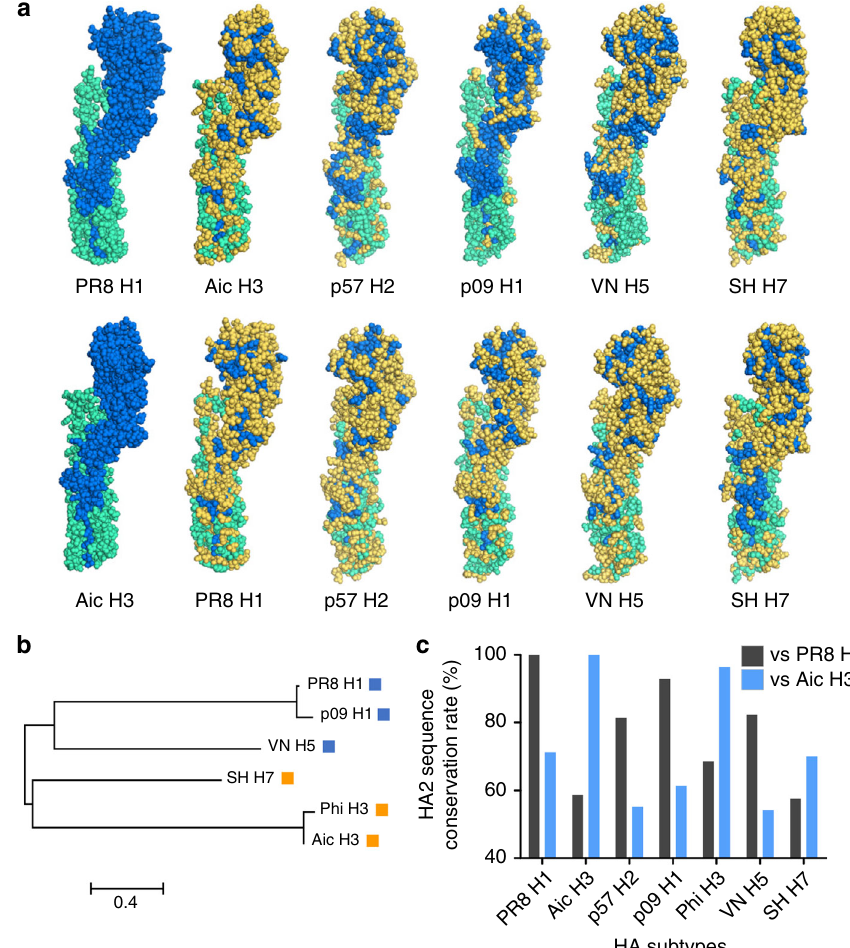
Fig. 4 Amino acid differences in HA structures. a Three-dimensional spherical structures of diverse hemagglutinin proteins with amino acid variations against PR8 H1 or Aic H3. The HA1 domain is shown in green-cyan and the HA2 domain is shown in blue. The different residues in other HA proteins against PR8 H1 or Aic H3 are colored in yellow. (PR8 H1 PDB: 1rvx; Aic H3 PDB: 3ztj; p57 H2 PDB: 4hf5; p09 H1 PDB: 5gjs; VN H5 PDB: 2fk0; SH H7 PDB: 5v2a). b Phylogenetic tree of HAs. The squares besides HA subtypes indicate HA phylogenetic groups by coloring: blue for group 1 and orange for group 2. c HA2 domain sequence conservation rate against PR8 H1 and Aic Fig. 4d). IgG2a-biased antibody responses were induced, as evi- denced by the IgG1:IgG2a ratio (Supplementary Fig. 4e).